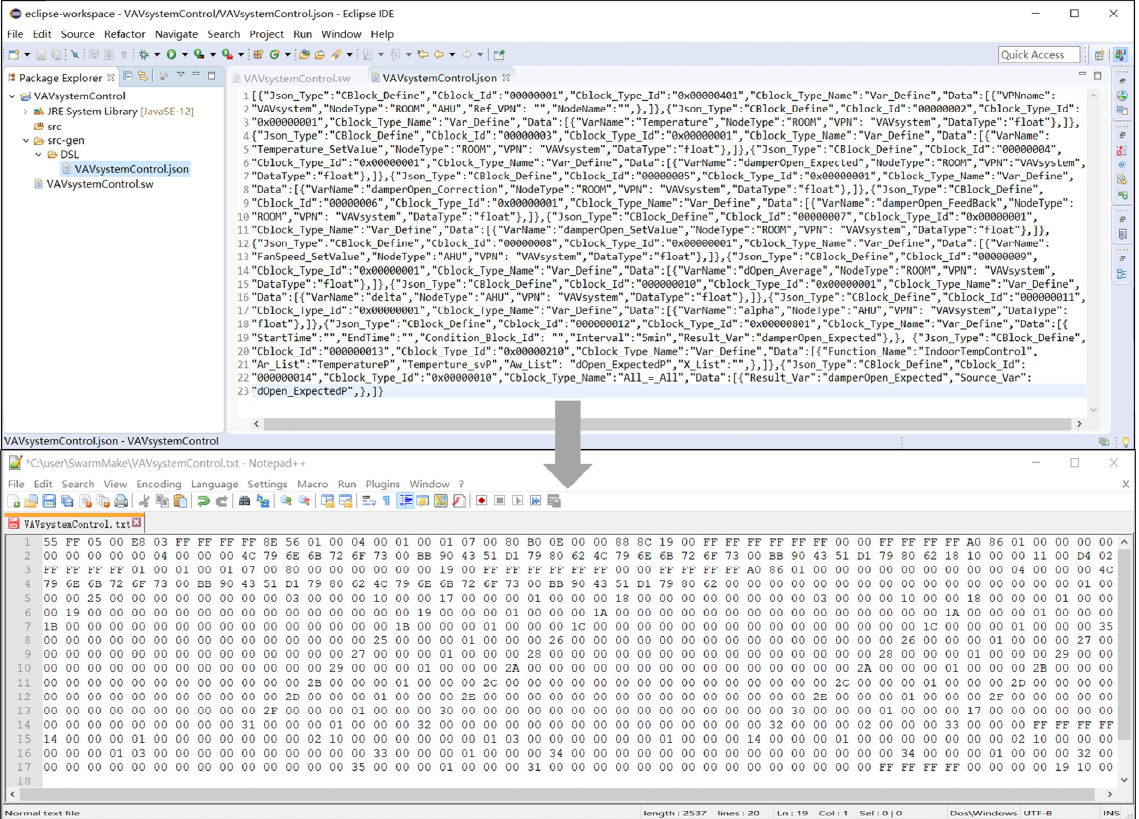
Figure 13. Object code generation